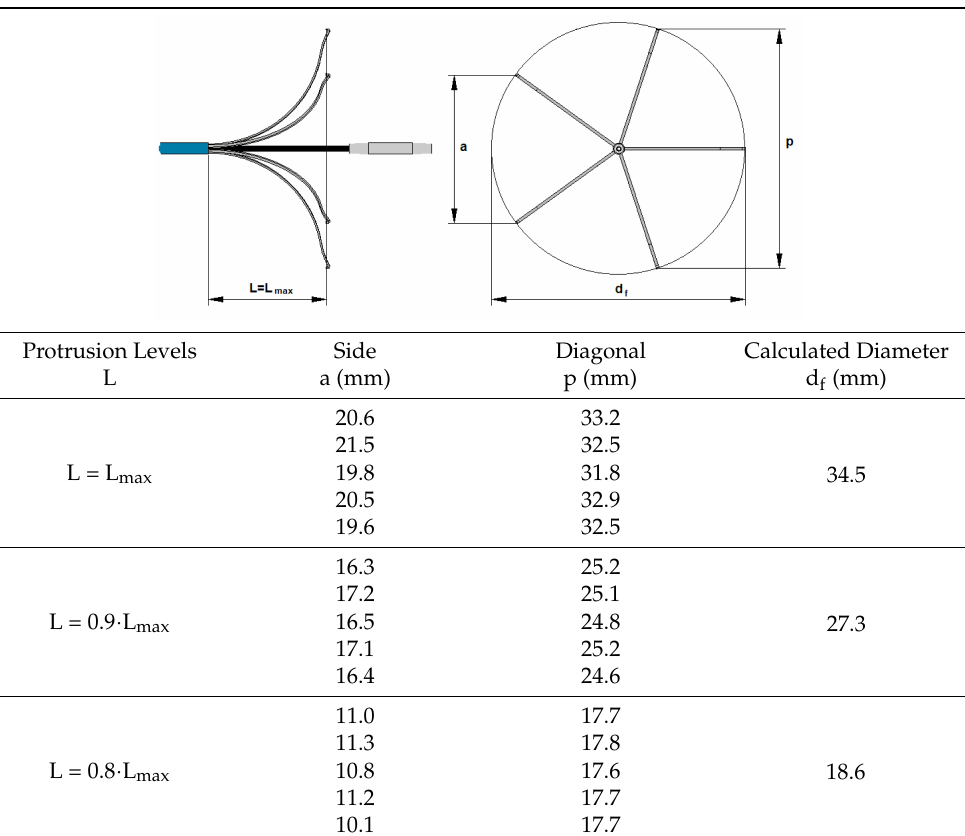
Table 1. Results of measurements and calculations of Flebogrif geometrical